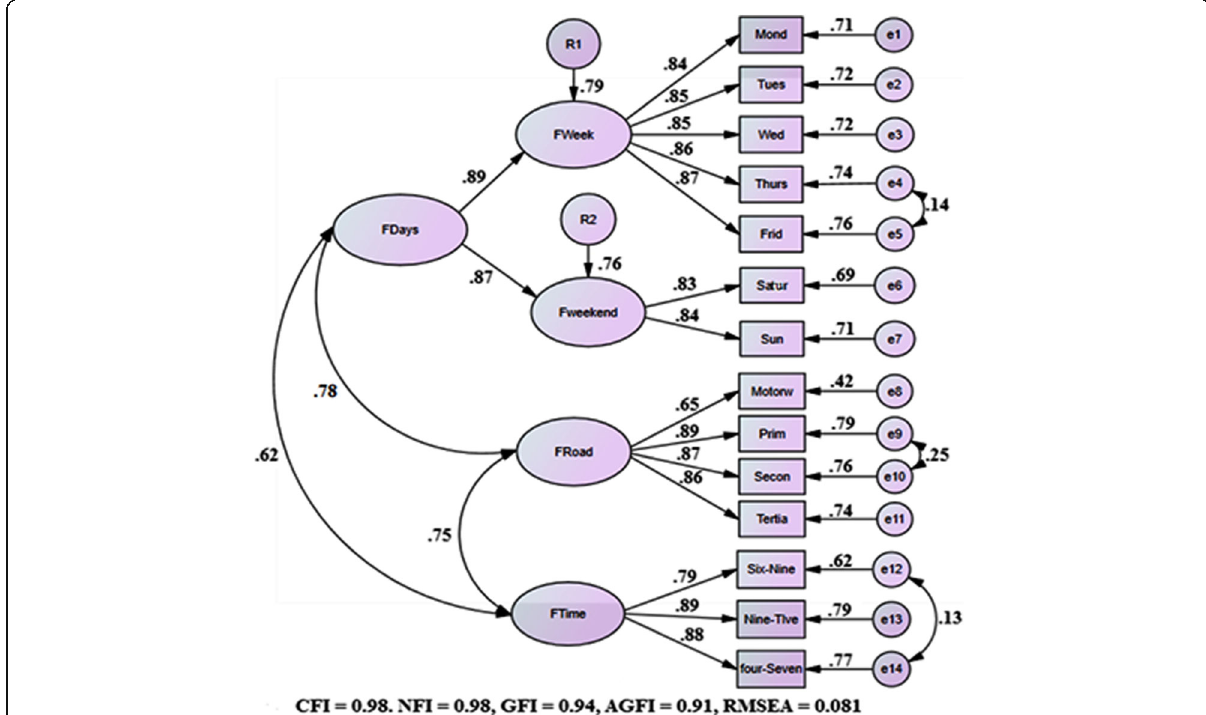
Fig. 2 Measurement model. *Note: Monday – Mond, Tuesday – Tues, Wednesday – Wed, Thursday – Thurs, Friday – Frid, Saturday – Satur, Sunday – Sun, Motorway – Motorw, Primary roads – Prim, Secondary roads – Secon, Tertiary roads – Tertia, 6 am to 9 am – Six-Nine, 9 am to 12 noon – Nine-Tlve, 4